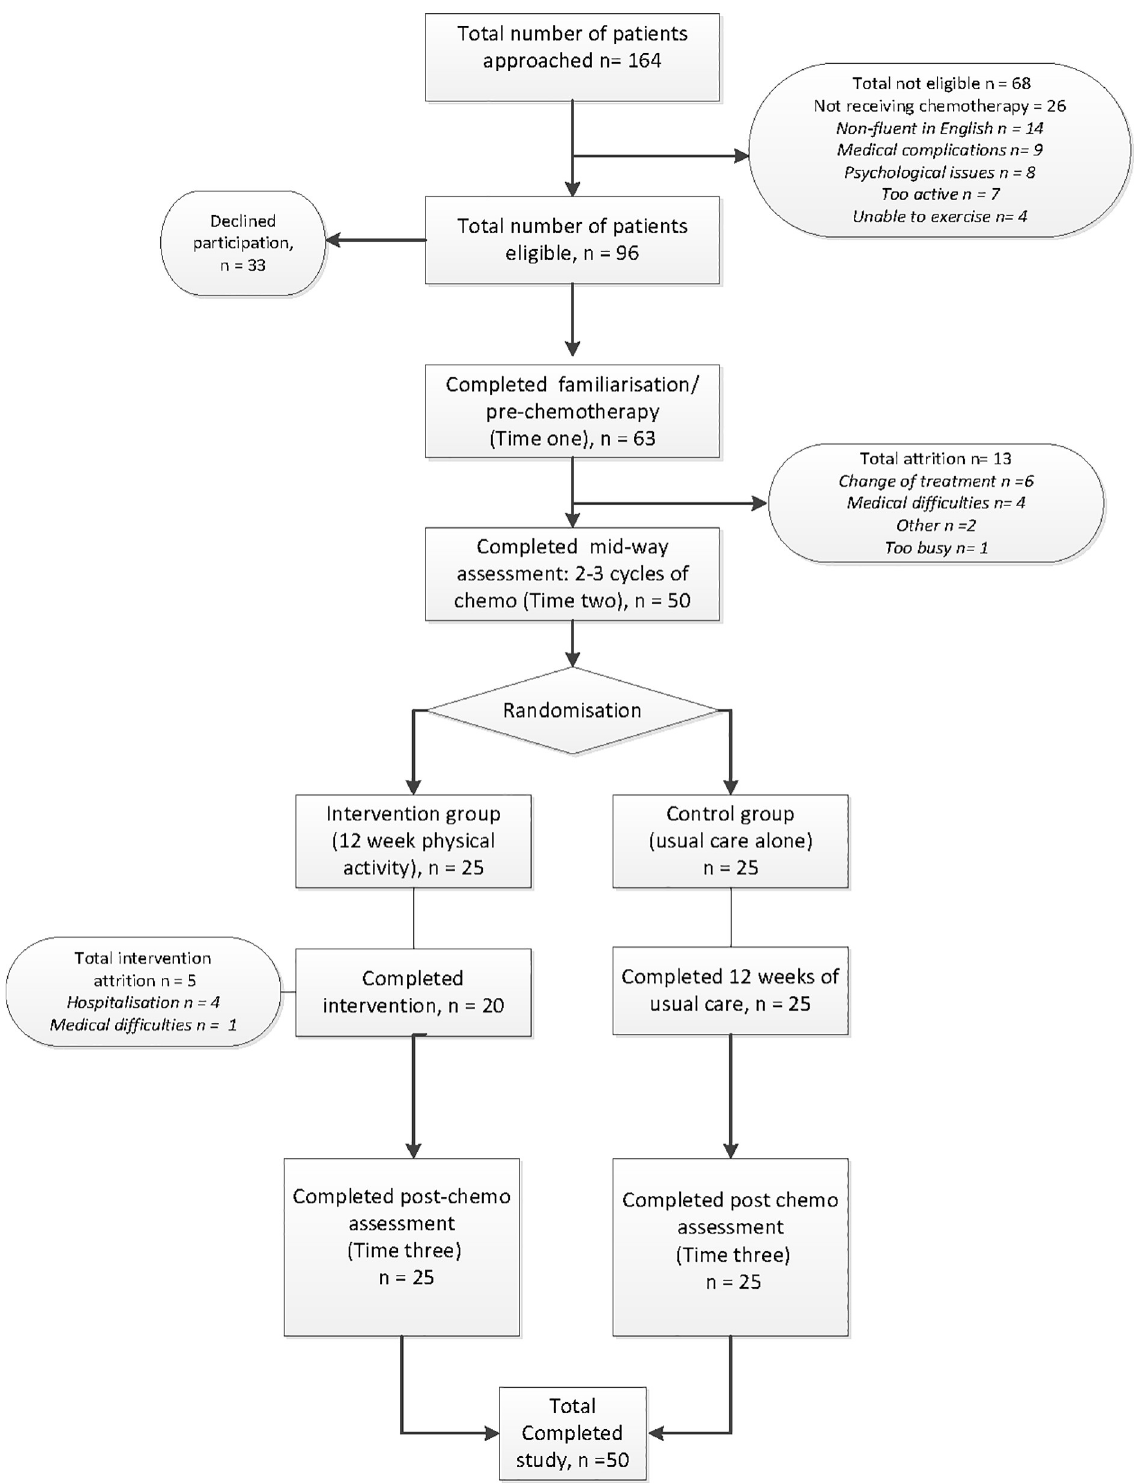
Fig 1. CONSORT Flowchart: Study recruitment and attrition rates.